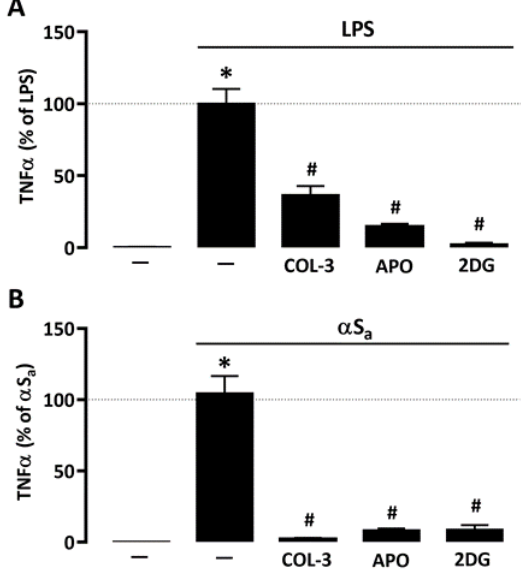
Figure 6. Inhibitory effects of COL-3 on TNF- α release are reproduced by inhibition of either glucose metabolism or NADPH oxidase activity. ( A ) Quantification of TNF- α levels in microglial cell cultures exposed or not to LPS (10 ng/mL, 24 h) in the presence or absence of COL-3 (20 µ M), APO (300 µ M), or 2-DG (500 µ M). Data are the mean ± SEM ( n = 6). * p < 0.05 vs. control; # p < 0.05 vs. LPS. One-way ANOVA followed by Bonferroni post-hoc test. ( B ) Quantification of TNF- α levels in microglial cell cultures exposed or not to α Sa (70 µ g/mL, 24 h) in the presence or absence of COL-3 (20 µ M), APO (300 µ M), or 2-DG (500 µ M). Data are the mean ± SEM ( n = 6). * p < 0.05 vs. control; # p < 0.05 vs. α Sa. One-way ANOVA followed by Bonferroni post-hoc test.